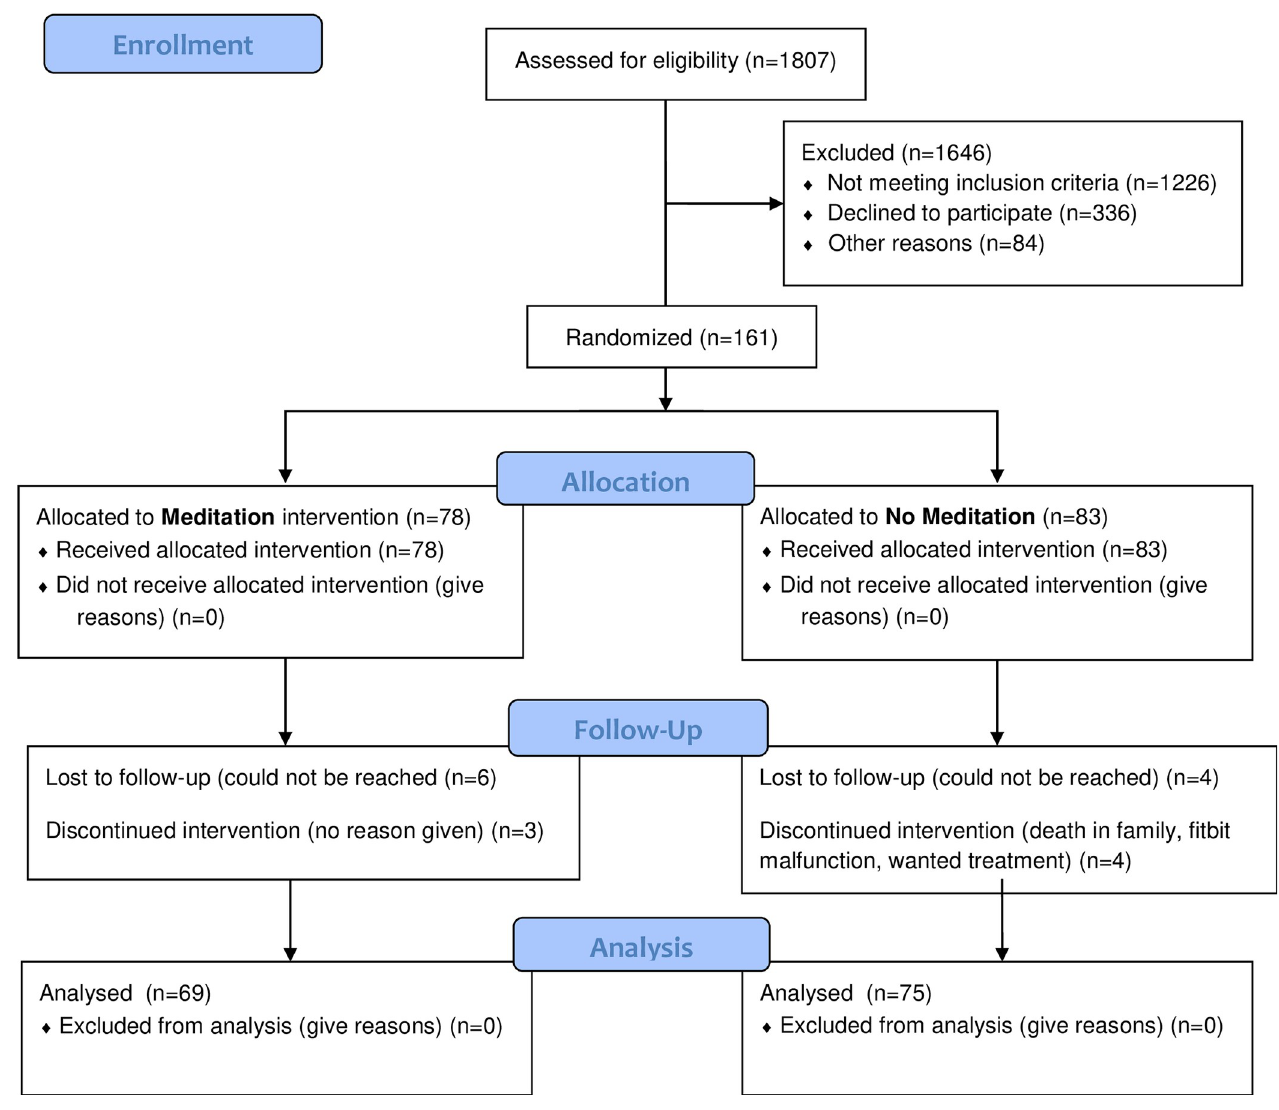
Fig 1. CONSORT flow